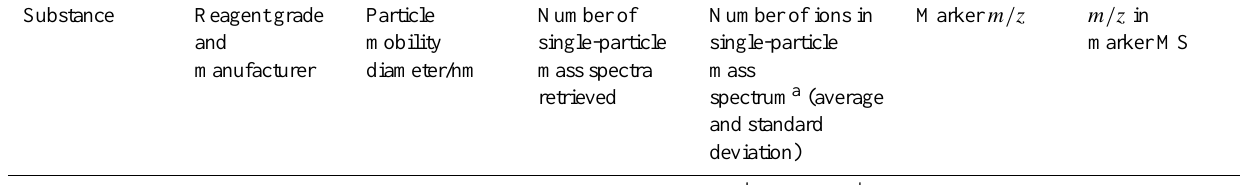
Marker m/z m/z in